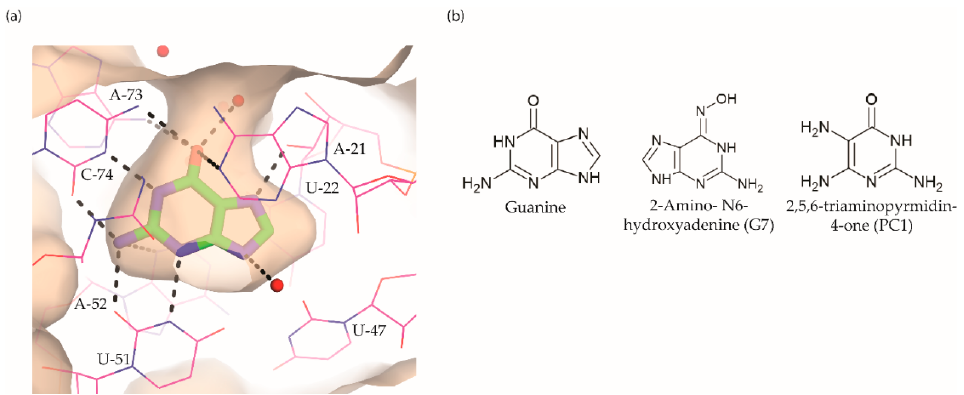
Figure 5. Guanine riboswitch ligands. ( a ) The binding pocket of the guanine riboswitch in complex with guanine (PDB ID: 6UBU). The solvent accessible surface is shown in wheat colour, the ligand with green colour, polar contacts as black dotted lines and water molecules as red spheres. (b) Chemical structure of the guanine riboswitch ligands.